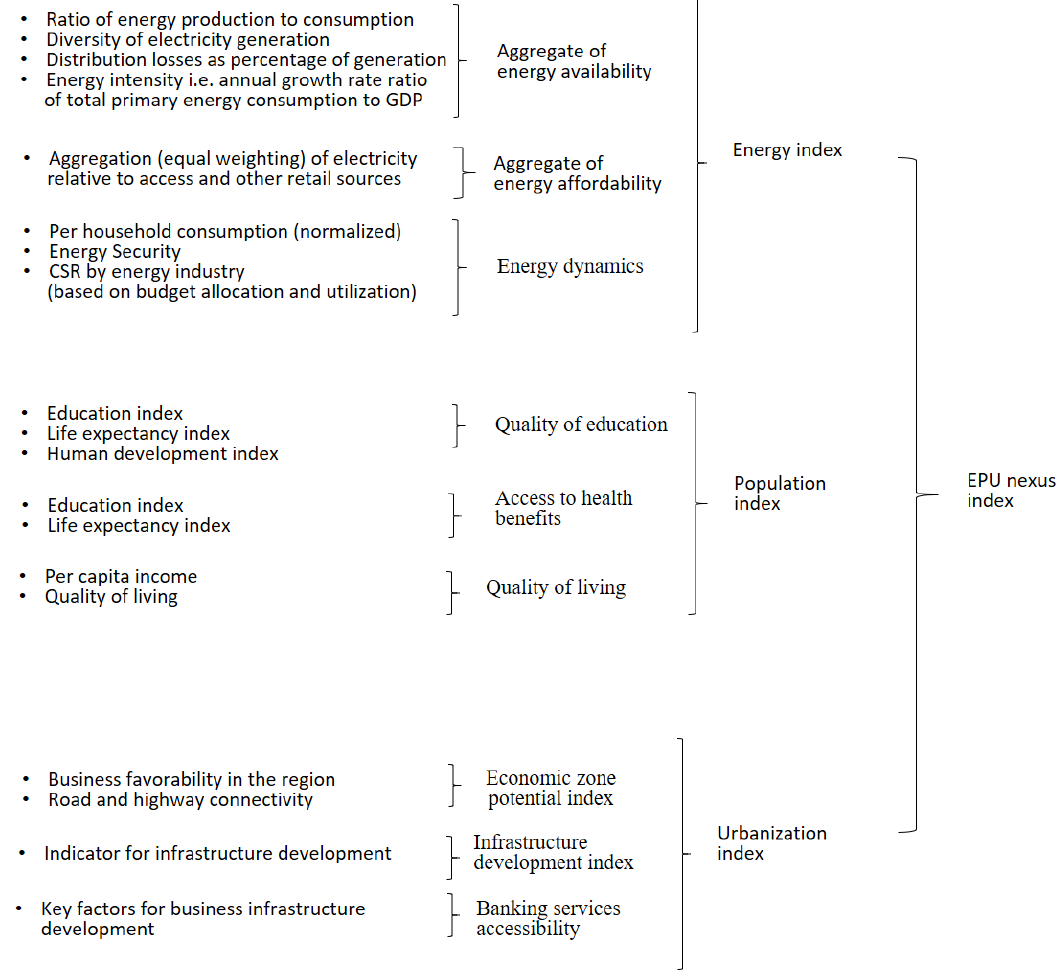
Figure 3. Hierarchical aggregation of quantifiable indicators of calculation of energy, population, and urbanization indices and for calculation of EPU index.